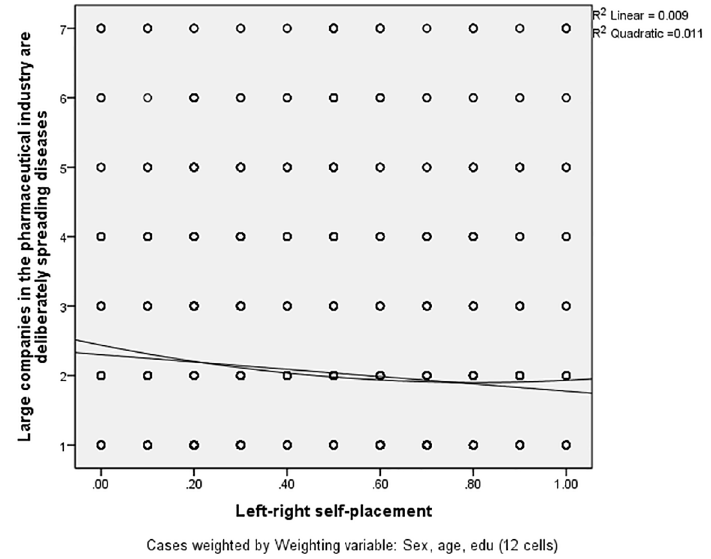
Figure 3. Linear and quadratic relationship between political ideology and belief that large companies in the pharmaceutical industry are deliberately spreading